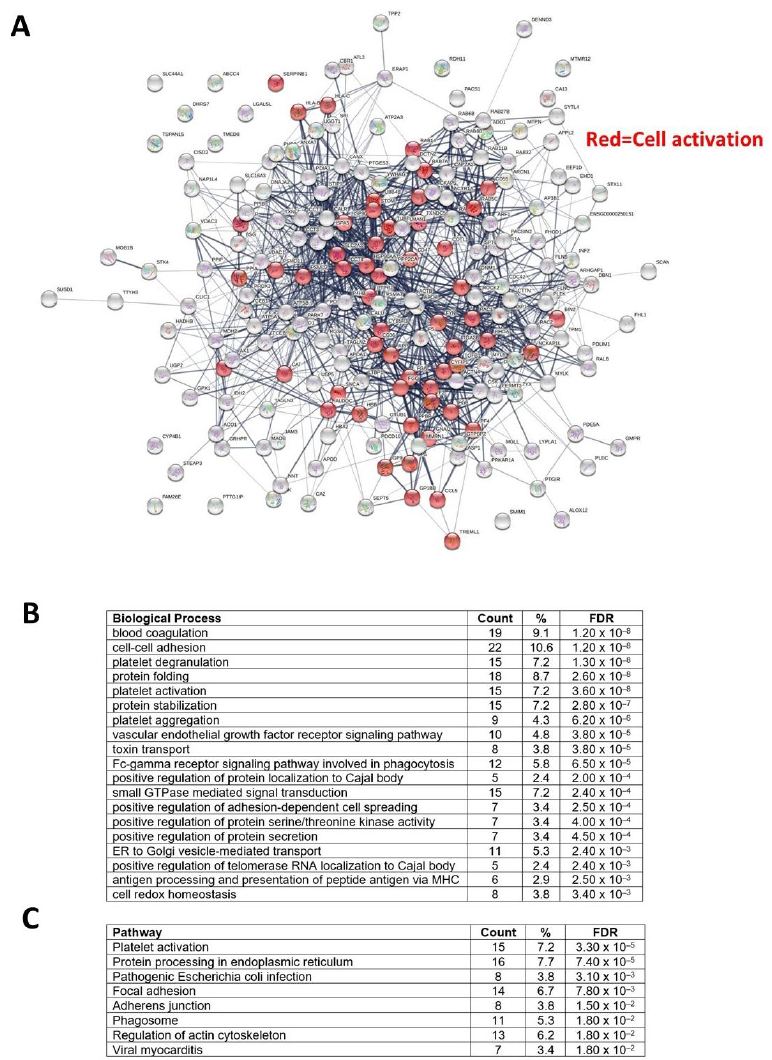
Figure 11. Network and pathway analysis of the significantly modulated proteins in platelet-derived EVs from CRC compared to controls (HS). ( A ) The proteins interaction network of the 208 identified proteins (showed as nodes in the network) modulated in CRC compared to controls (using STRING v11) is reported; proteins associated with “cell activation” are highlighted in red. ( B ) Biological processes of the significantly modulated proteins were obtained using DAVID Bioinformatics Resources. ( C ) Significantly modulated proteins were submitted to DAVID for Gene Ontology analysis, and the results for KEGG pathway analysis are